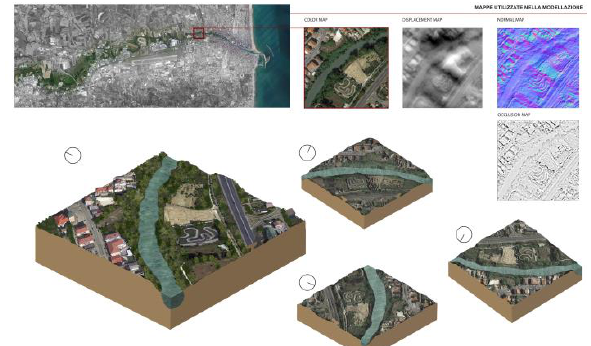
Figure 17: low-poly model obtained from photoplan and satellite data.